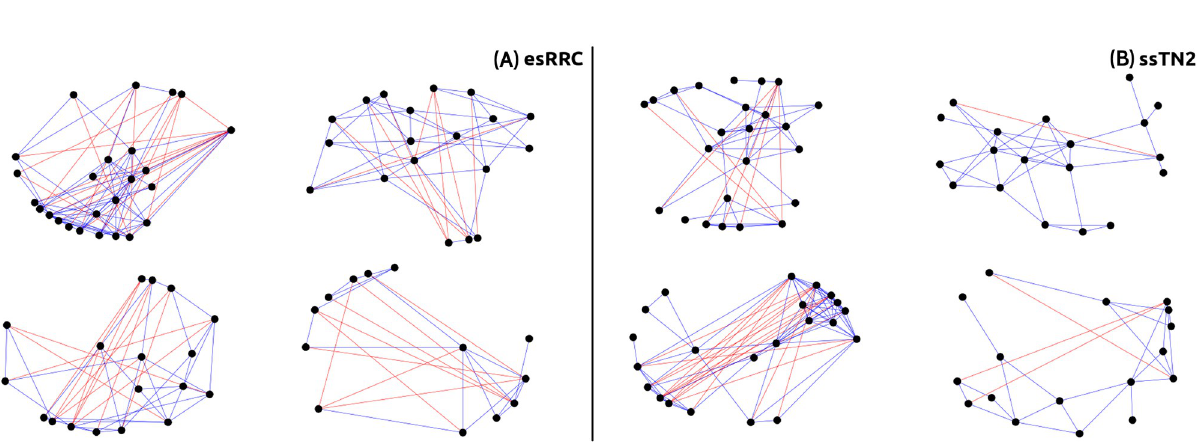
Fig 7. Signed communities examples. (A) Four signed communities from esRRC elementary school (Newman method). Communities with negative hubs and with two antagonistic subgroups are observed. (B) Four signed communities from ssTN2 high school (greedy method). There are phenomena similar to the previous one but in smaller